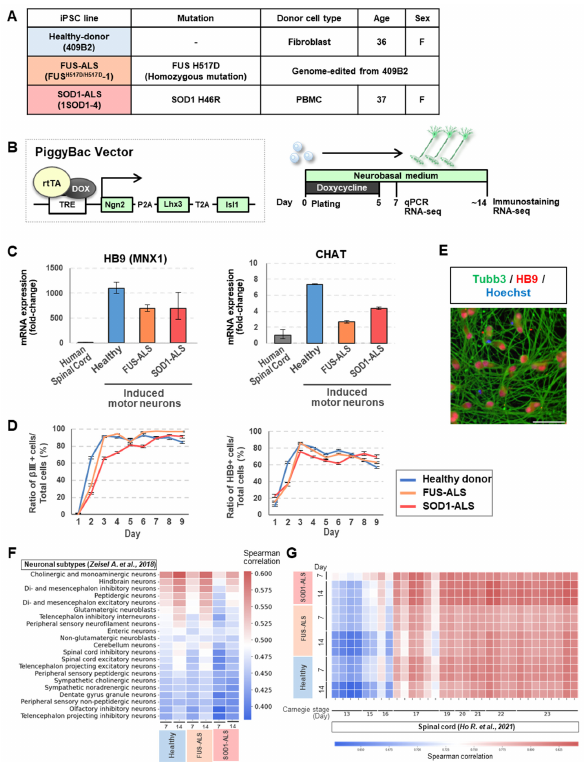
Figure 1. Generation of motor neurons from iPSCs. ( A ) Information about the iPSCs used in this study. ( B ) Experimental design of neuronal di ff erentiation and analysis; ( C ) mRNA expression lev- els of motor neuron markers on day 7 were determined by qPCR. Each value represents the mean ± SEM ( n = 3). ( D ) Induction e ffi ciency for motor neurons was evaluated for days 1–9. Each value represents mean ± SEM ( n = 16). ( E ) A representative image of healthy donor-derived motor neurons on day 7 immunostained for Tubb3 (green), HB9 (red), and Hoechst 33342 (blue). The scale bar rep- resents 50 µm. ( F ) The transcriptome of induced motor neurons on days 7 and 14 were compared to each cluster of annotated neurons from the adult mouse scRNA-seq dataset [25]. ( G ) The transcrip- tome of induced motor neurons on days 7 and 14 was compared to that of the human spinal cord at each Carnegie stage [26].